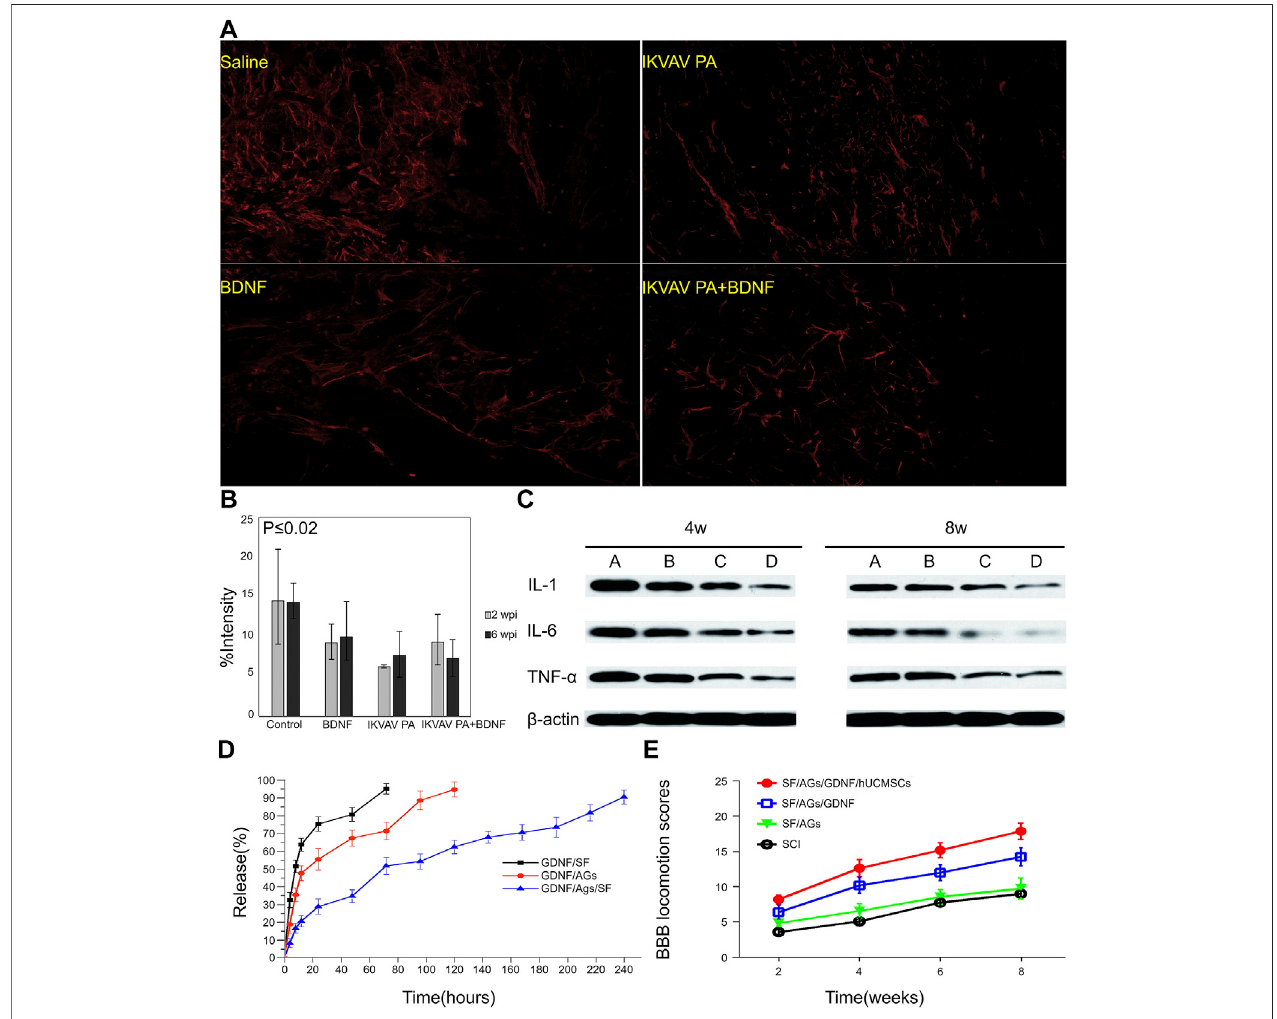
FIGURE6| Regulationofimmunemicroenvironmentbybiomaterialsloadedwithgrowthfactors. (A) Anti-GFAPimmunoreactivityintheinjuredsiteafter6weeksof hydrogel treatment in different treatment groups. (B) Quantitative analysis of the fl uorescence intensity of GFAP staining. (C) Western blot detection of in fl ammation- related markers at 4 and 8 weeks after treatment. A SCI group; B SF/AGs group; C SF/AGs/GDNF group; D SF/AGs/GDNF + hUCMSCs group. (D) Scaffold neurotrophic factor release curve. (E) Exercise scores of all treatment groups at different time points after treatment. Reproduced with permission from (110, 113).